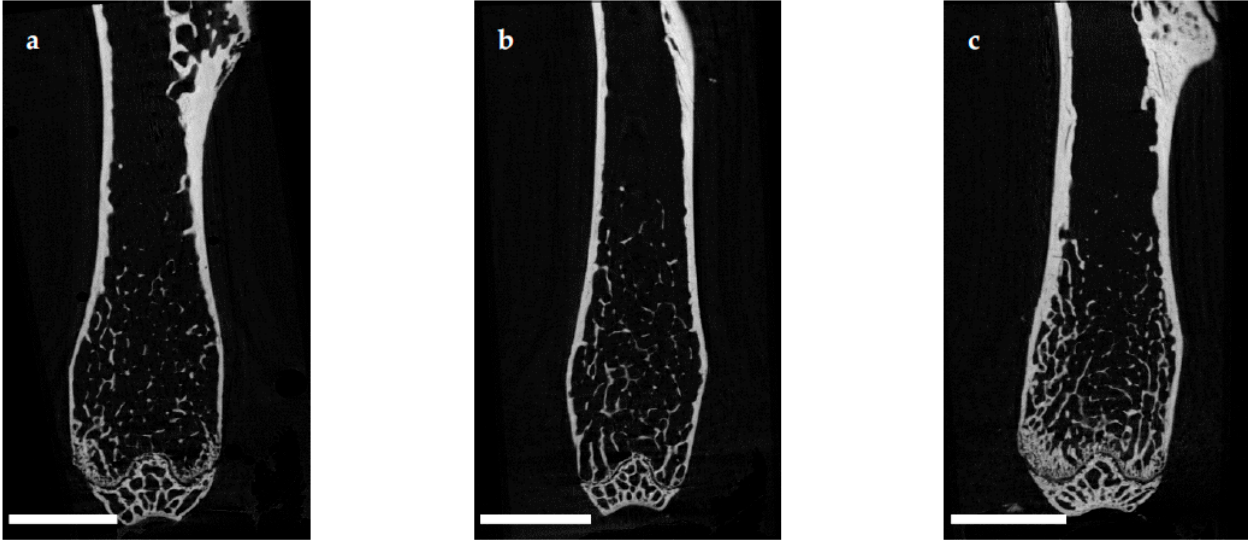
Figure 3. Two-dimensional images from µCT scans of distal femora (scale bar 2 mm). Mice were immunized with ( a ) testicular homogenate in adjuvant (EAO), ( b ) adjuvant alone or ( c ) remained untreated.